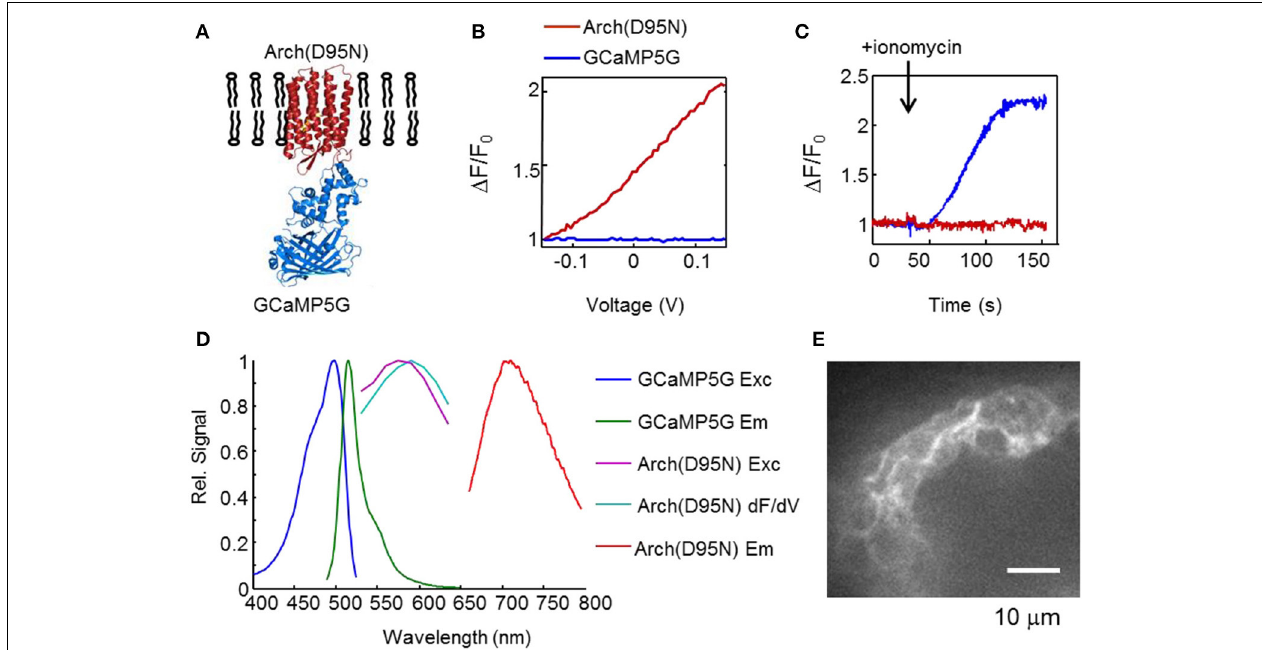
FIGURE 2 | CaViar reporter for simultaneous measurement of voltage and Ca 2 + . (A) Structure of CaViar: a fusion of the far-red voltage indicator Arch(D95N) with a blue/green calcium indicator (GCaMP5G). (B) Fluorescence response of CaViar to variations in membrane voltage in HEK cells. (C) Temporal response of CaViar to ionomycin which gradually raised the intracellular calcium concentration from ∼ 100nM to 1.8mM. In (B , C) , the red trace indicates fluorescence of Arch(D95N), and the blue trace indicates fluorescence of GCaMP5G. (D) Spectral properties of GCaMP5G (courtesy of Douglas Kim, Janelia Farm) and Arch(D95N). The excitation and emission spectra of Arch(D95N) were